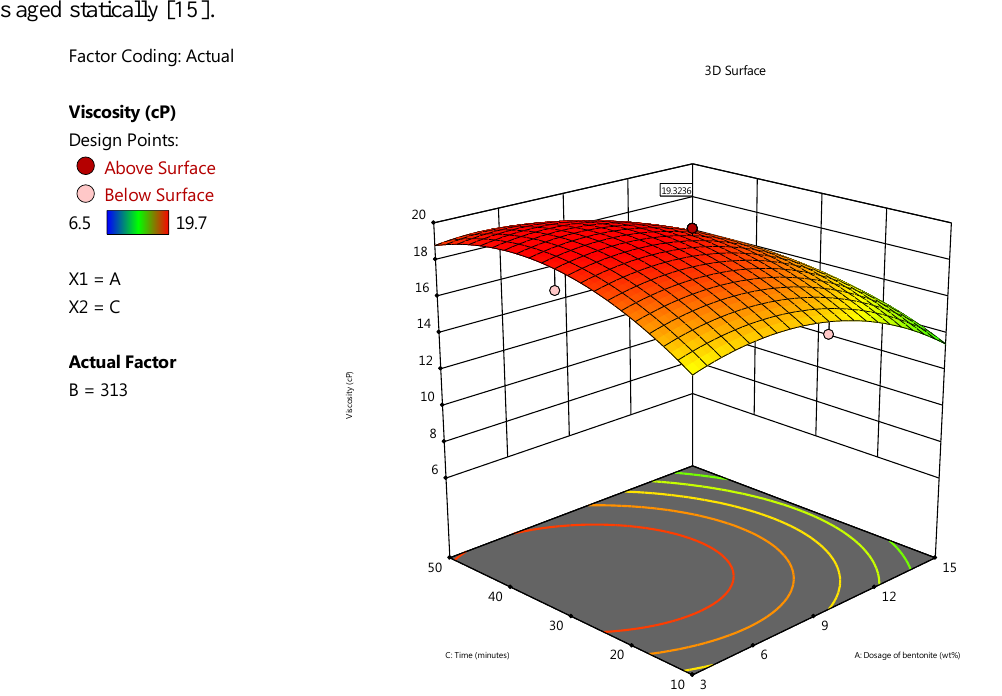
Figure 5. Effect of time and dosage of bentonite on viscosity of